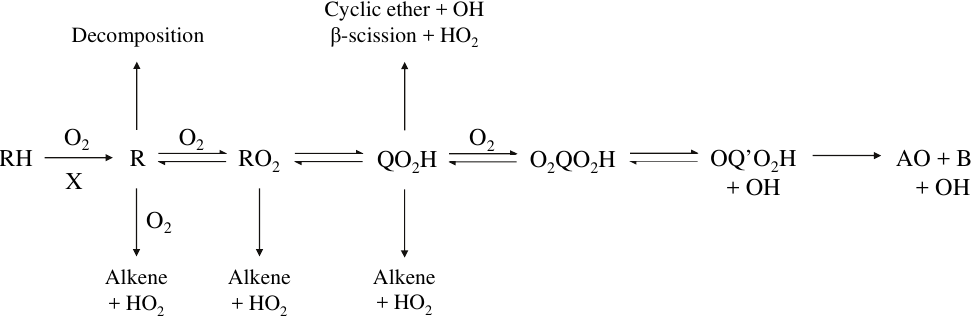
Fig. 1. Mechanism of alkane oxidation: RH – alkane, R – alkyl radical, OH – hydroxyl radical, HO 2 – hydroperoxy radical, X – various radicals, AO, BO – molecular oxygenated species